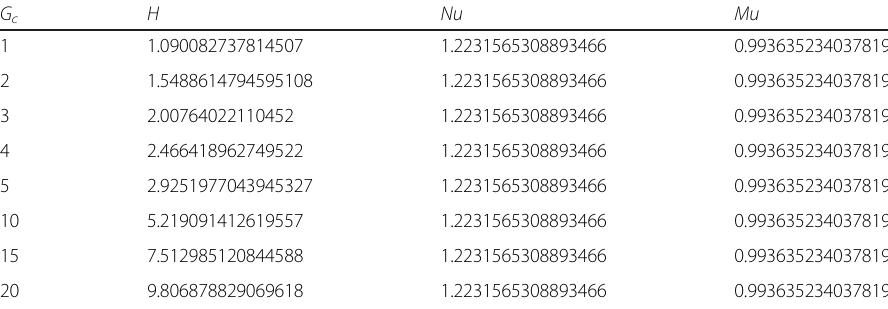
Table 3 Values of skin friction (H), Nusselt number ( Nu ), and Sherwood number ( Mu ) for different values of G c G c H Nu